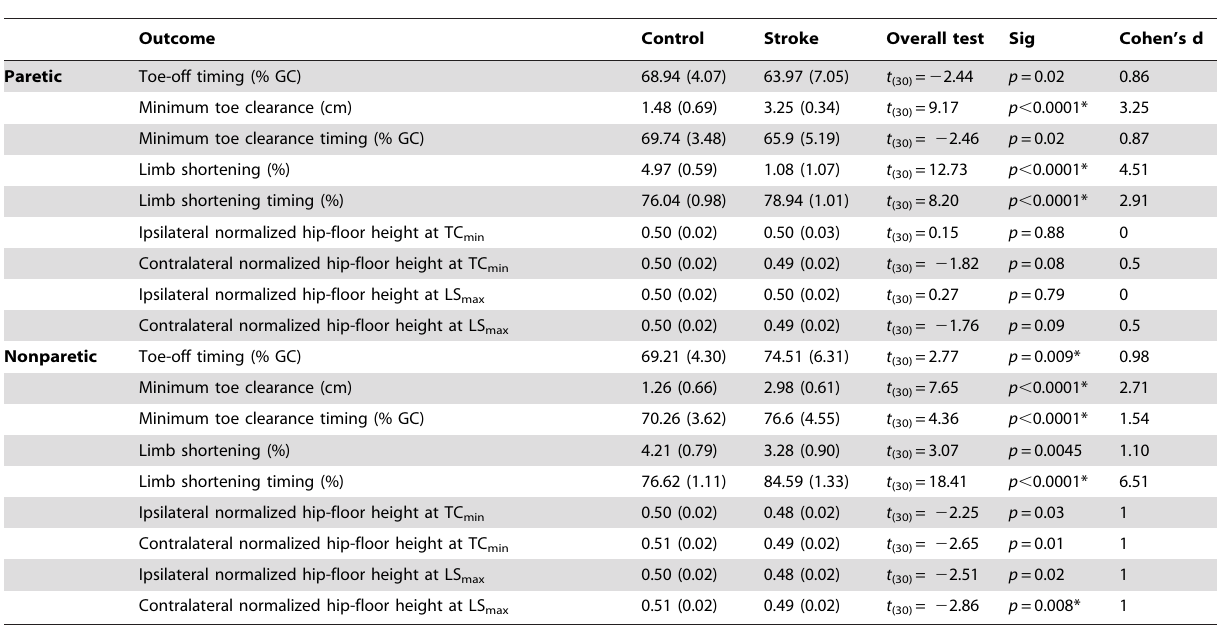
Table 1. Timing and magnitude of gait events.